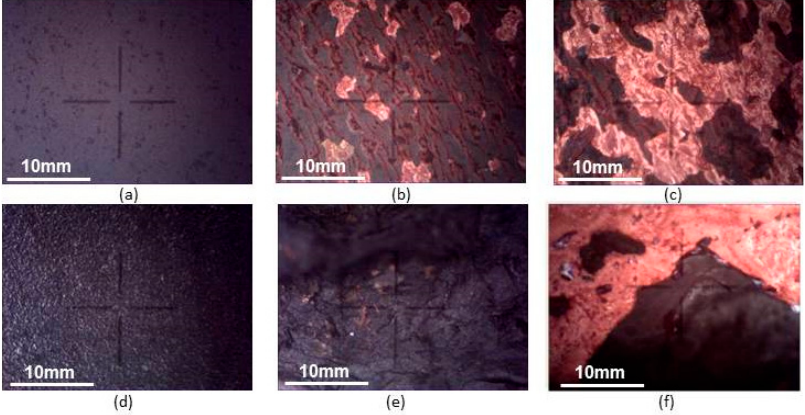
Figure 6. Optical images of the coating surface based on Zr-Y-O. A coating without ion treatment in initial state ( a ), after 2 cycles ( b ), after 3 cycles ( c ); a coating with ion treatment of the copper substrate by the Ti ions: the initial state ( d ), 33 cycles ( e ), 40 cycles ( f ).